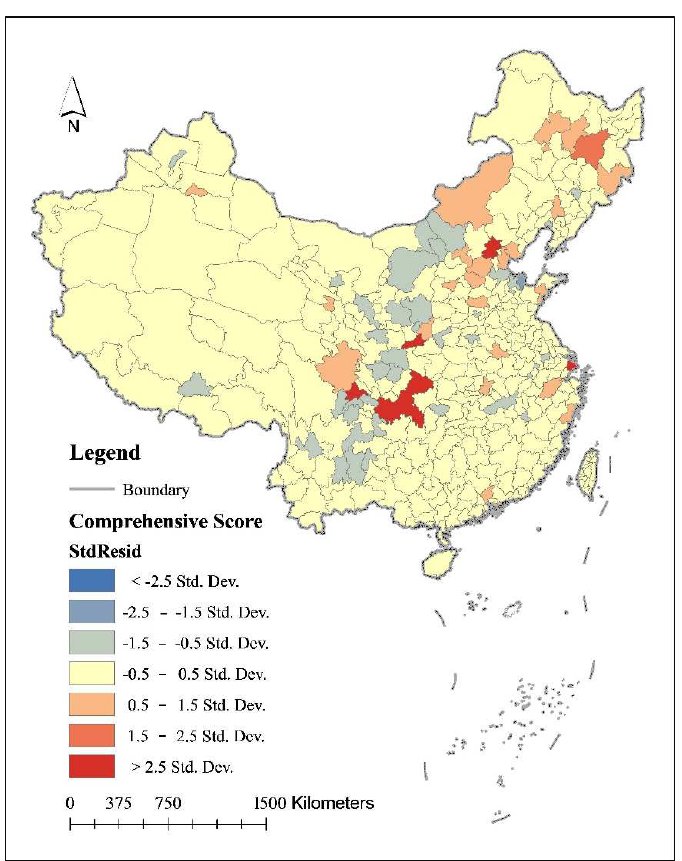
Figure 6. Geographically weighted regression analysis of urbanization factors on carbon emissions of urban households in China.